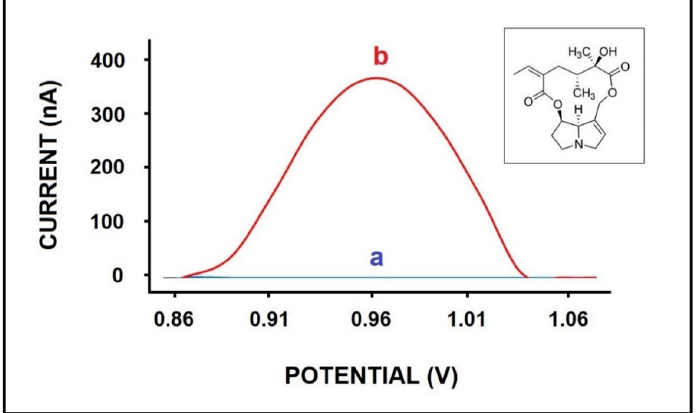
Figure 1. Voltammograms of (a) control experiment performed by PGE in PBS in the absence of SEN; (b) oxidation signal of 50 µg/mL SEN. Inset figure presenting the chemical structure of SEN. The effect of immobilization time on the immobilization efficiency of SEN onto the PGE surface was examined based on changes in the response. An amount of 50 µg/mL SEN (its stock solution was prepared in DMSO) was immobilized onto the electrode sur- face during 15, 30, and 60 min, and the oxidation signal of SEN was measured respectively as 200.50 ± 74.39 nA (RSD%, 37%, n = 3), 241.67 ± 31.07 nA (RSD%, 12%, n = 3), and 197.80 ± 40.08 nA (RSD%, 20%, n = 3) (Figures 2 and S2). Since the highest and reproducible oxi- dation signal of SEN was measured in 30 min immobilization time (Figure 2), it was cho- sen as the optimum immobilization time. Figure 2. Histograms representing the result in the absence of SEN (control experiment performed in PBS alone) and the average oxidation signal of 50 µg/mL SEN ( n = 3) after its immobilization onto the PGE surface for 15 min, 30 min, and 60 min immobilization time.